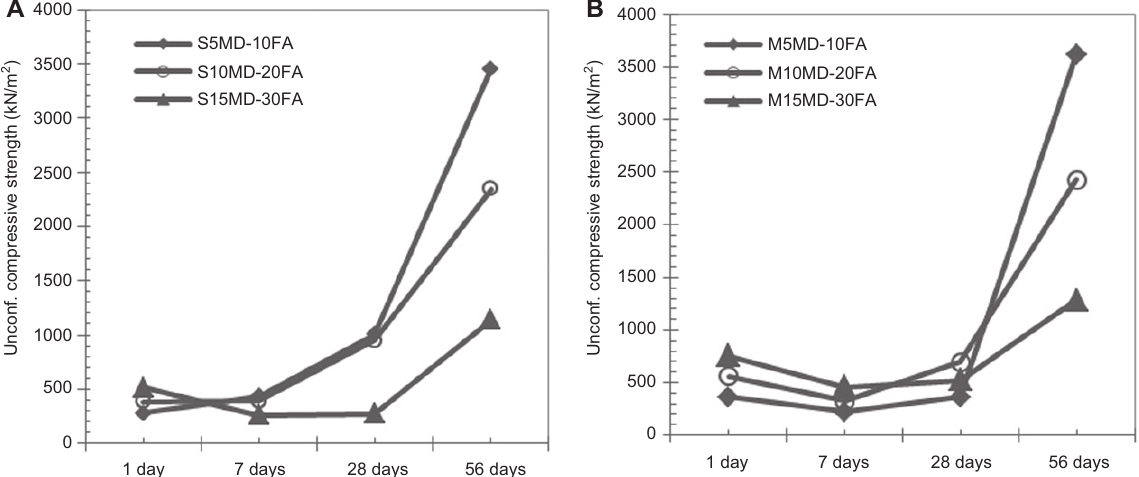
Figure 5 Influence of curing time on the specimens. (A) Specimens with SPE. (B) Specimens with